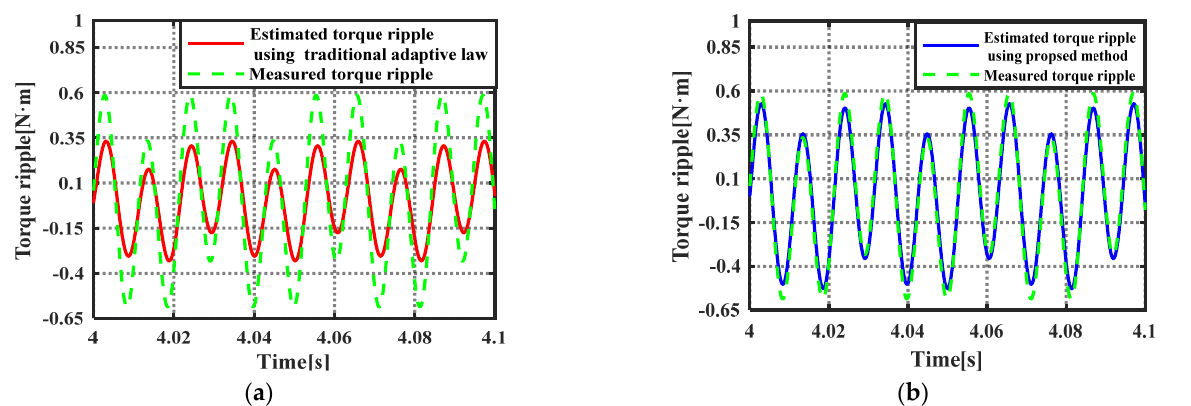
( d ) Figure 8. Output torque curves with three control methods and their FFT analysis. ( a ) Output torque curves using three control methods; ( b ) FFT analysis of the output torque by using PI controller; ( c ) FFT analysis of the output torque by using SMC; ( d ) FFT analysis of the output torque by using ASMC. To further verify the effectiveness of the proposed adaptive law, the torque ripple estimated results using (17) and the proposed method are compared in Figure 9. As can